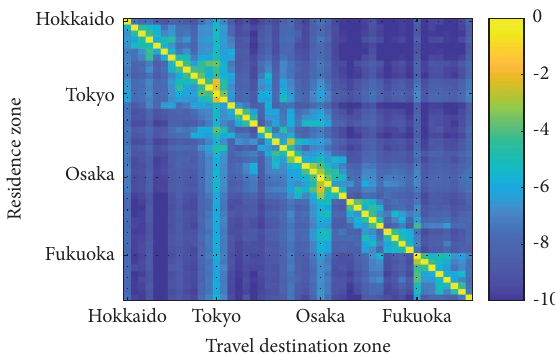
Figure 3: Observed matrix B